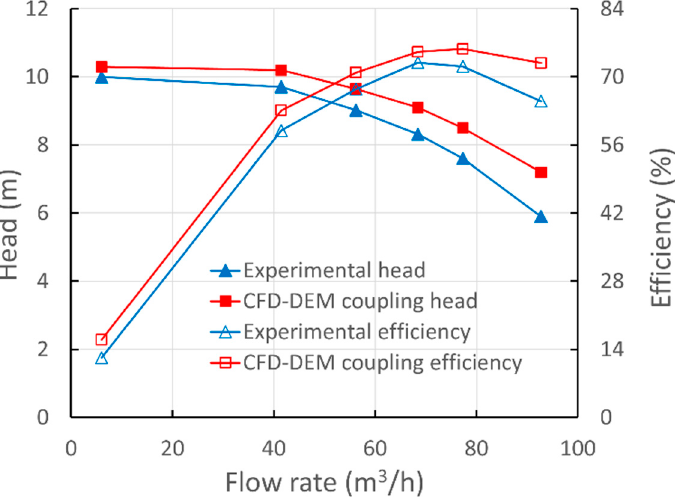
Figure 4. Comparison of the pump head and efficiency between the simulation and experimental data.